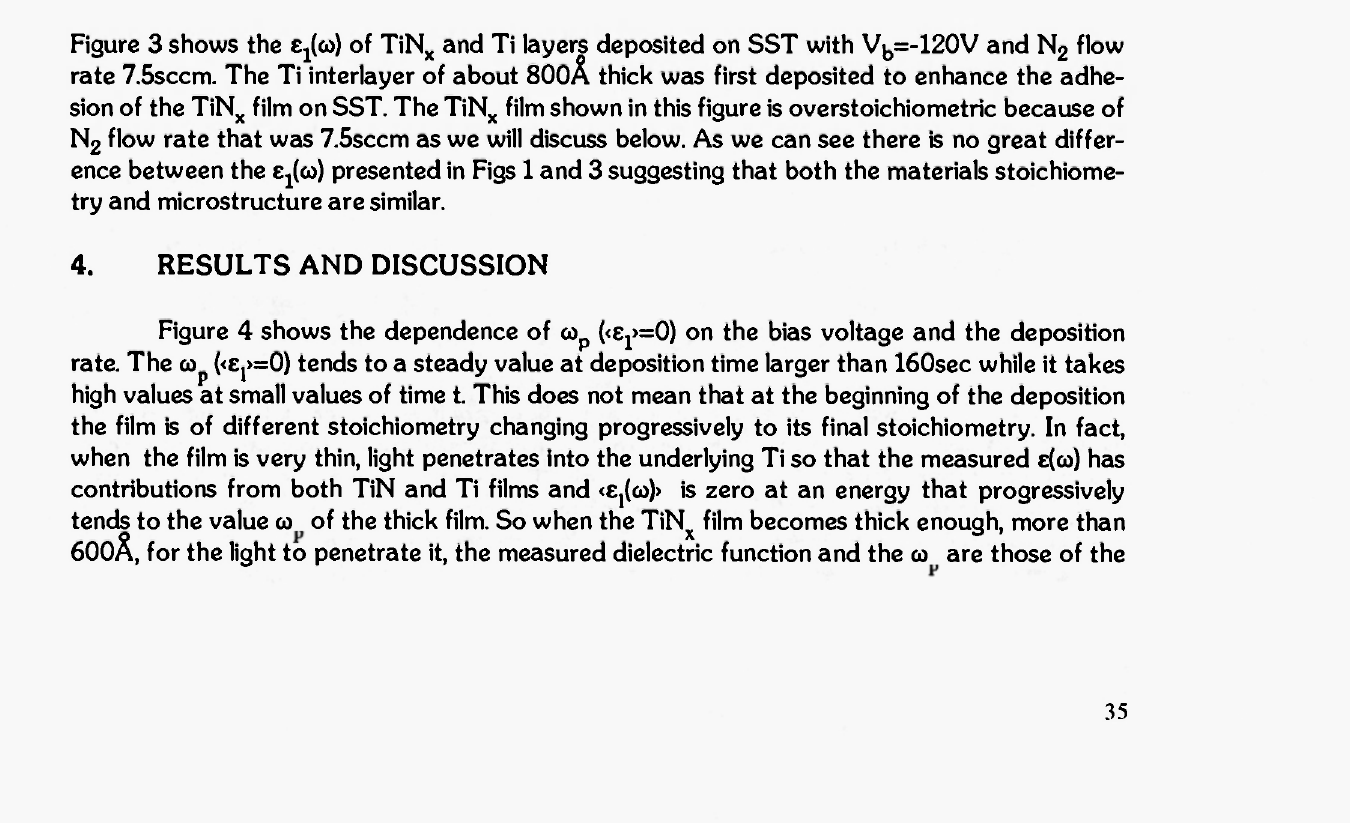
Fig. 3: The «ε^ of Ti and TiN layers depos- Fig. 4: The dependence of ω ρ on the bias voltage for TiN x ited on SST with